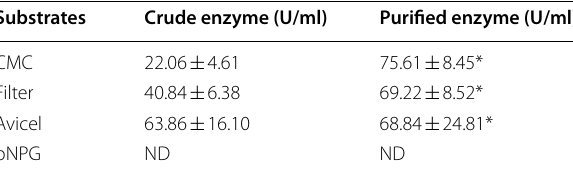
Table 4 Substrates specificity of crude and purified recom- binant enzyme Egls